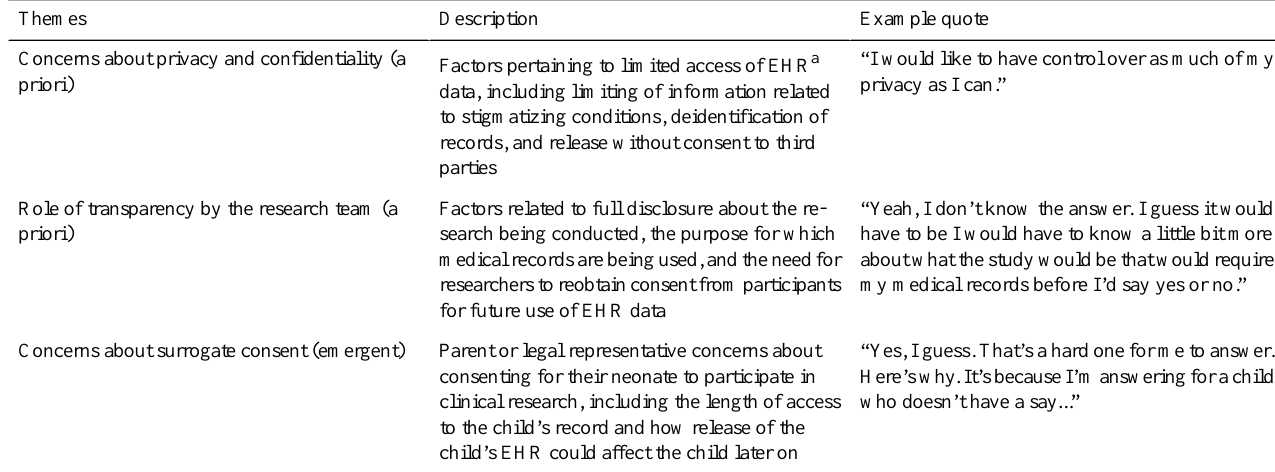
Table 1. A priori and emergent